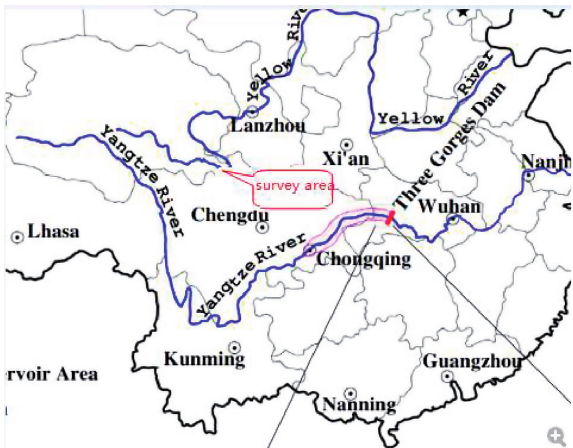
Figure 1: The geographical location of the study